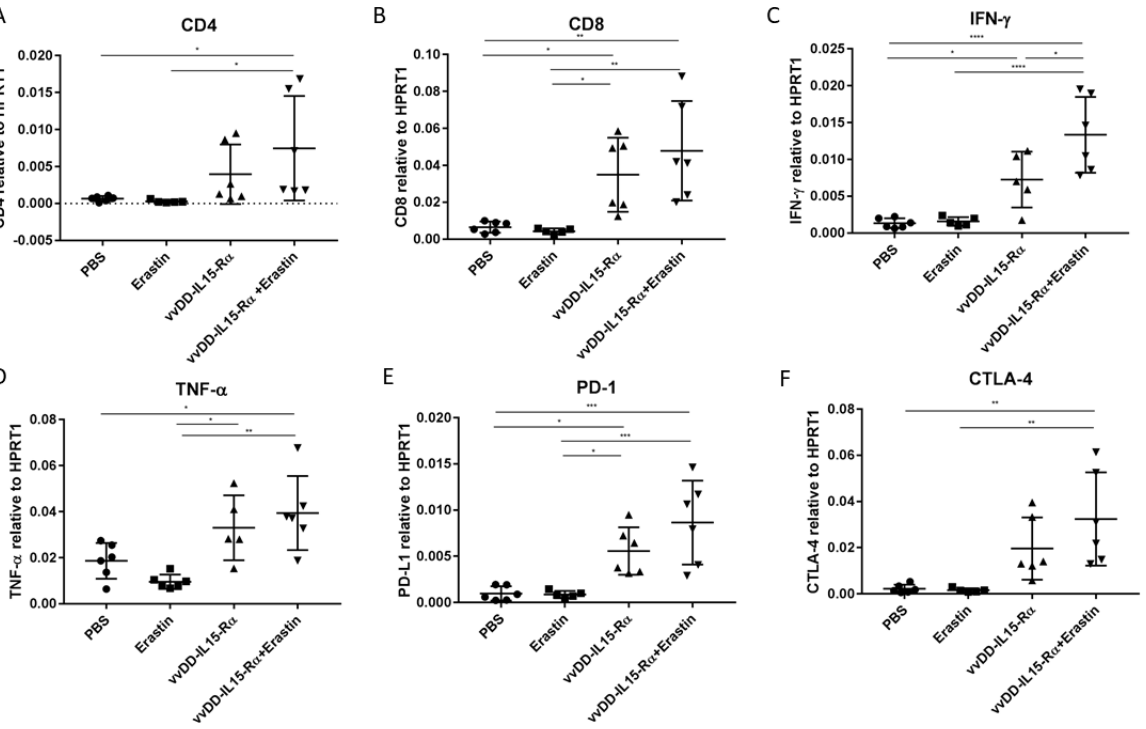
Figure 6. Tumor microenvironment (TME) is dynamically modified post combination therapy. Tumors are from the experiment depicted in Figure 5C, which were used to isolate RNA for RT-qPCR analyses. Expression levels of all markers are expressed relative to the housekeeping gene HPRT1. The expression levels of ( A ) CD4, ( B ) CD8, ( C ) IFN- γ , ( D ) TNF- α , ( E ) PD-1, and ( F ) CTLA-4 are presented. The symbols for the statistics are, *, p < 0.05; **, p < 0.01; ***, p < 0.001; ****, p < 0.0001.